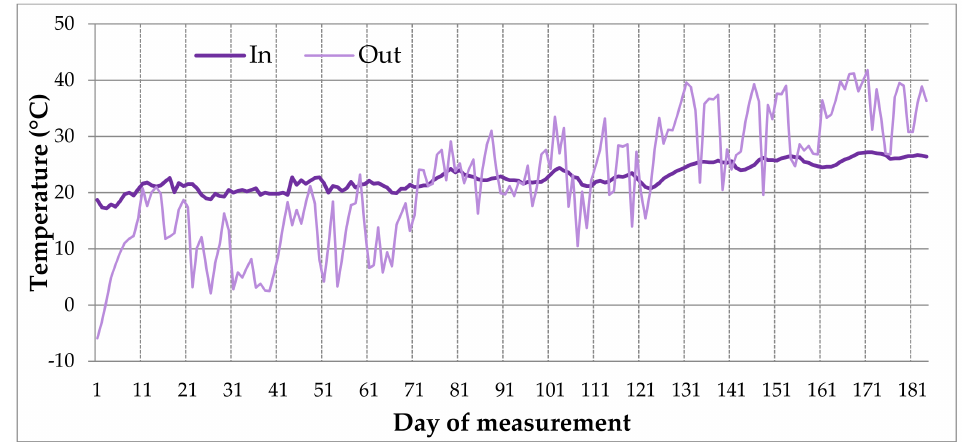
Figure 3. Daily variations of indoor/outdoor temperatures during the measurement period.